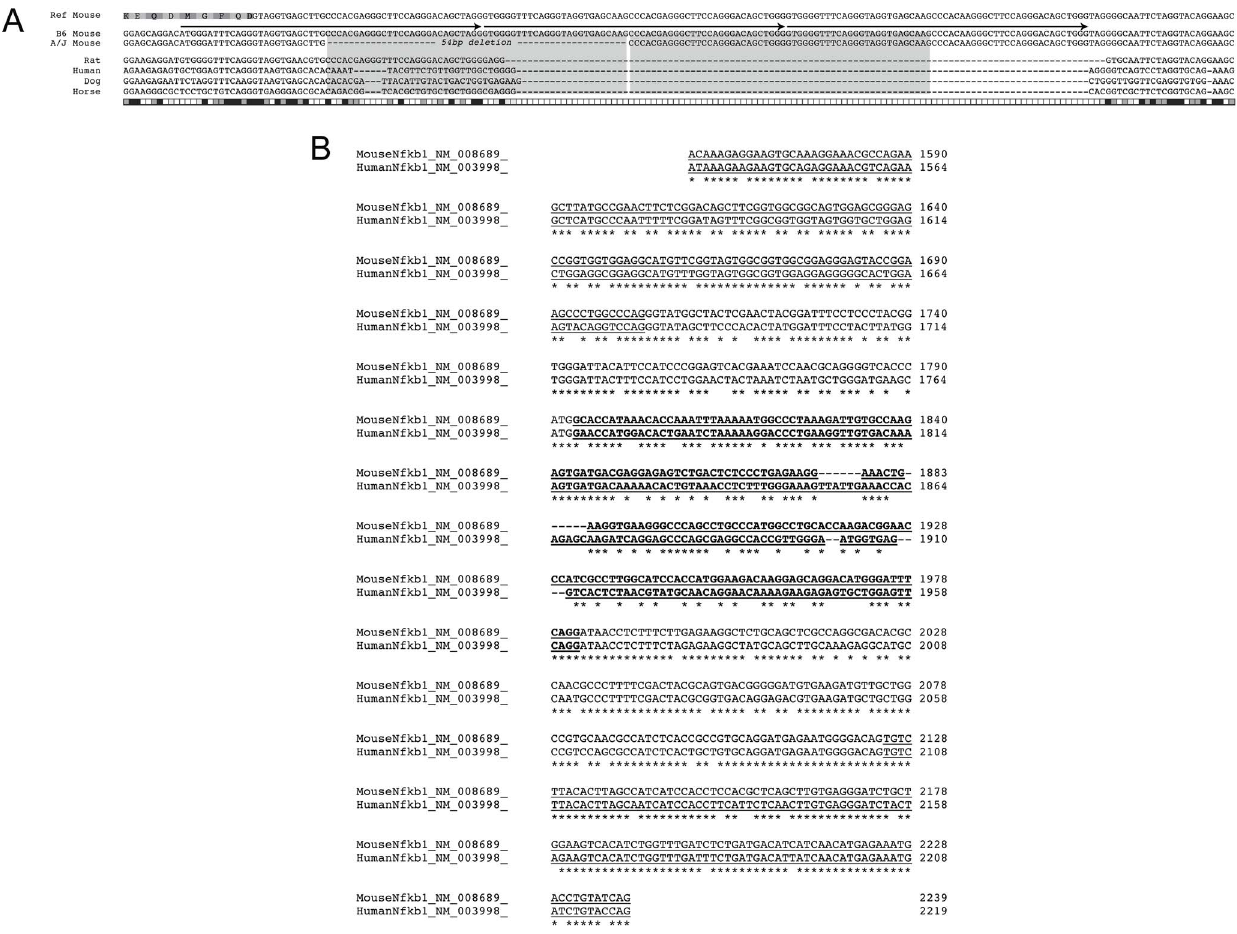
Figure 5. Cross-species sequence conservation of proximal intron 15 of the Nf k b1 gene. A . ClustalW alignment (EBI) of Nf k b1 intron 15 sequences from different species (shown at the left of the alignment). The reference mouse sequence from B6 is shown on top, including the single letter amino acid code for the polypeptide segment coded by exon 15. The genomic sequence of A is shown exactly as in Fig. 3B, including the deleted 54 bp duplication (‘---’) and the 3-repeat DNA motif overlapping the 3 9 splice site of exon 15 (Arrows). Both mouse sequences (B6 and A) have been aligned to corresponding rat, dog, horse and human genomic sequences. Conservation of each mouse nucleotide is represented as shaded boxes at the bottom with high (black) to low (white) level conservation. B . Nf k b1 cDNA sequence encoded by exon 13 to exon 17 (displayed as alternating underlined and regular format for each exon) of mouse and human genes have been aligned. The least conserved portion of the sequence is that encoded by exon 15, which sequence is in bold characters. Conserved nucleotides across the sequence are identified